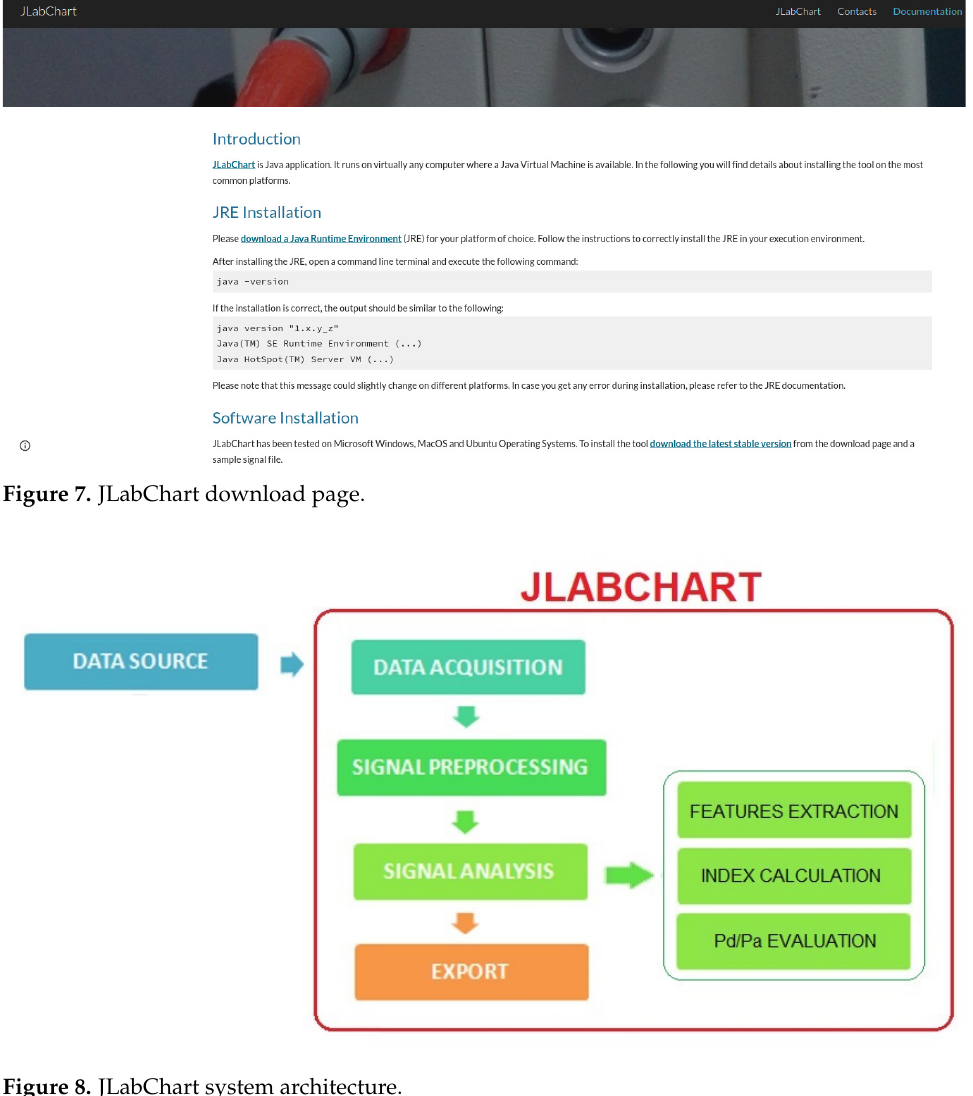
Figure 8. JLabChart system